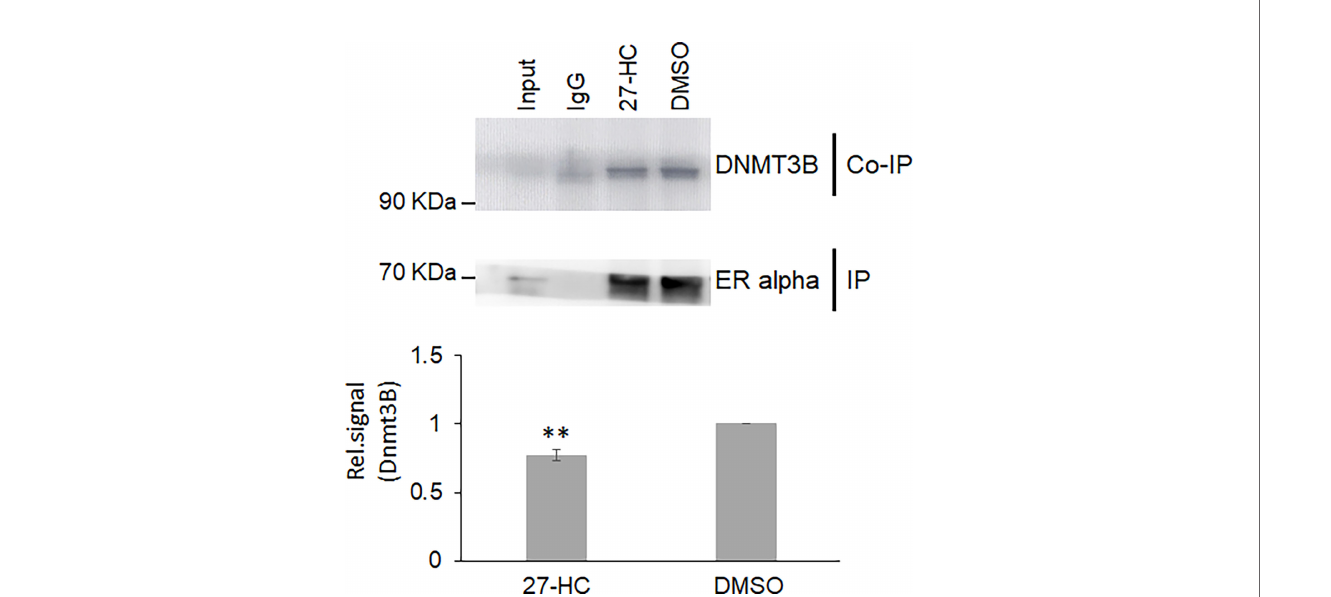
FIGURE 4 | The 27-hydroxycholesterol (27-HC) weakens the DNMT3B association with estrogen receptor alpha (ER a ): Co-immunoprecipitation (Co-IP) of ER a from DMSO- and 27-HC-treated cells has identi fi ed that the 27-HC causes a reduction in the association of DNMT3B with the ER a protein. The samples were separated on 12% gel and probed with the corresponding primary antibody. The ER a is used as a loading control. The bar graph represents the intensity of DNMT3B measured using ImageJ. The Co-IP assay was performed in triplicate, and the intensity of DNMT3B and ER a was measured using ImageJ. The normalized DNMT3B signal plotted and the error bar represent the standard error calculated from the biological triplicates. The p values were calculated using paired t-test, and the differences were considered signi fi cant at p values < 0.01